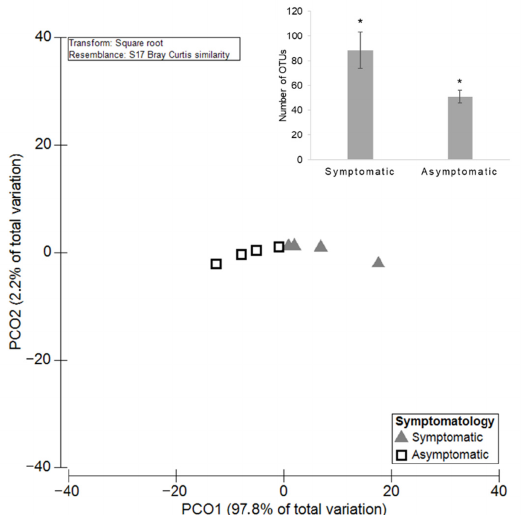
Figure 2. Principal Coordinates Analysis (PCO) based on the diversity of the fungal communities among GTDs symptomatic and asymptomatic grapevines. The average of the total OTUs number for both groups is shown in bar plot and significant differences ( p < 0.05) are indicated by asterisks.